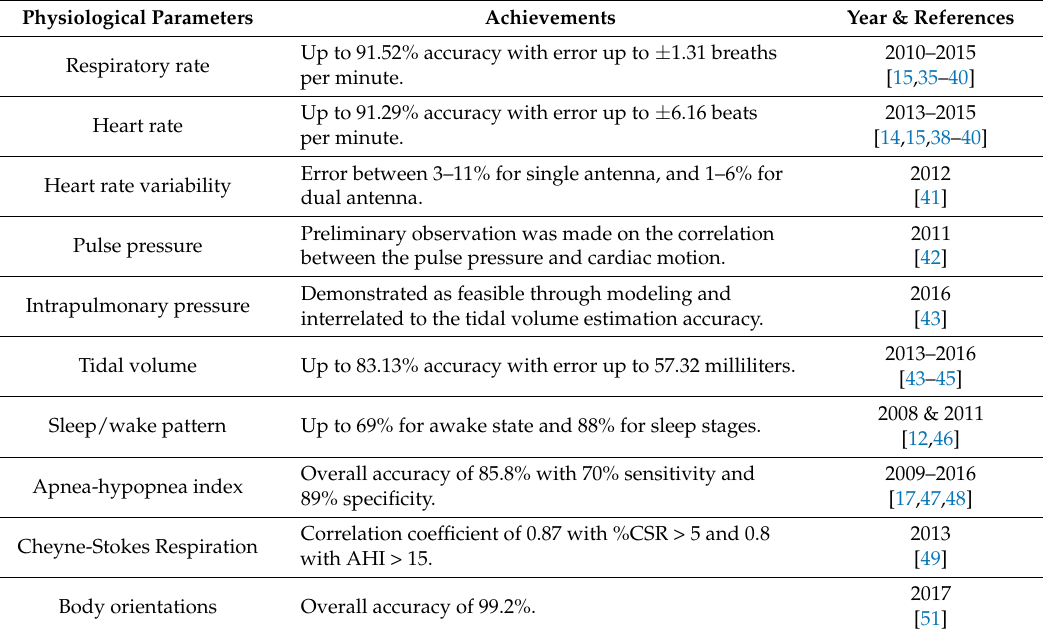
Table 2. Sleep monitoring using non-contact Doppler radar